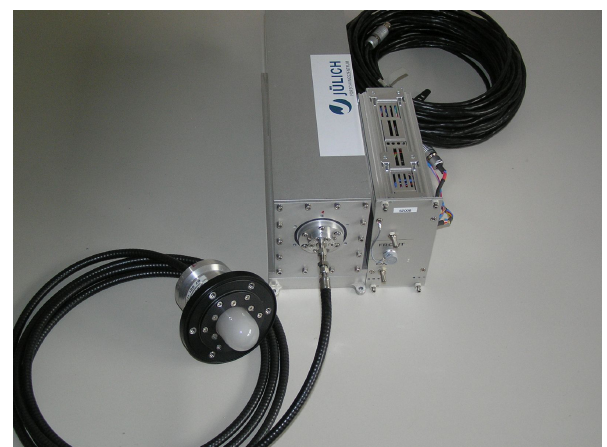
Figure 1. Basic components of a CCD array spectroradiometer sys- tem for airborne measurements. The 2 π receiver optics with optical fiber (black, front), spectrometer including the monochromator and CCD array detector (middle), and the cooling electronics